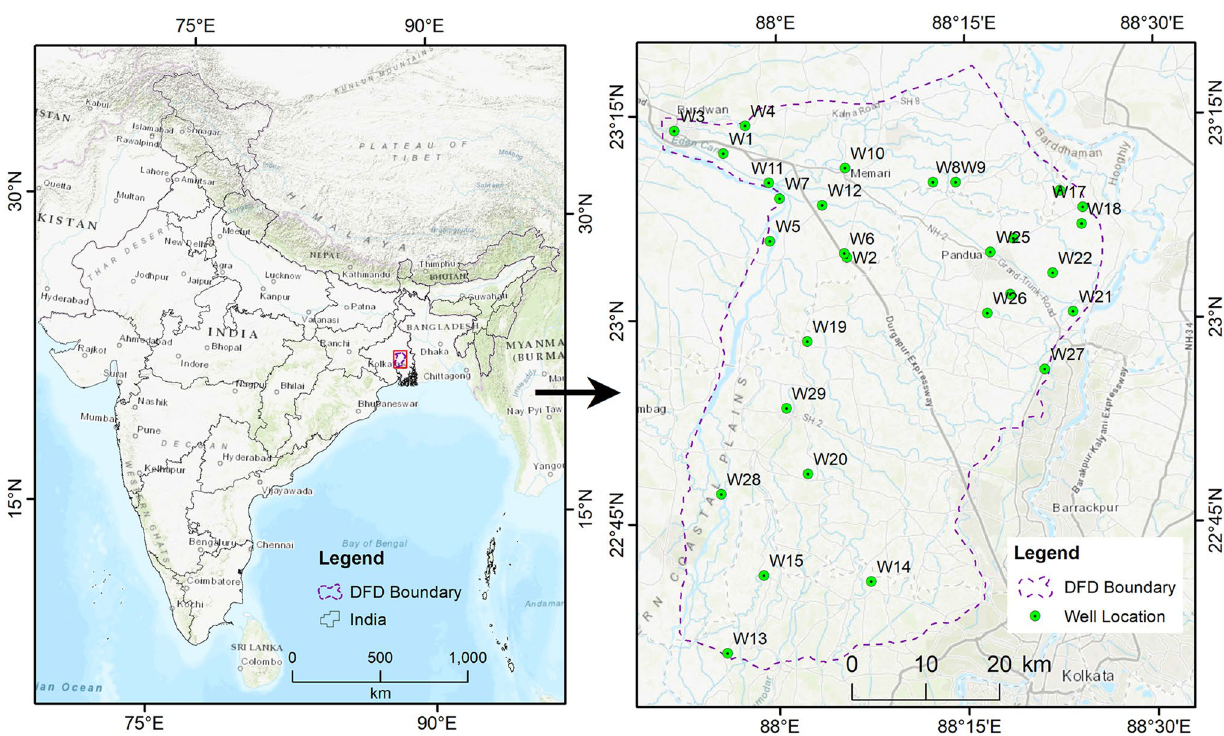
Fig. 1 Location of the study